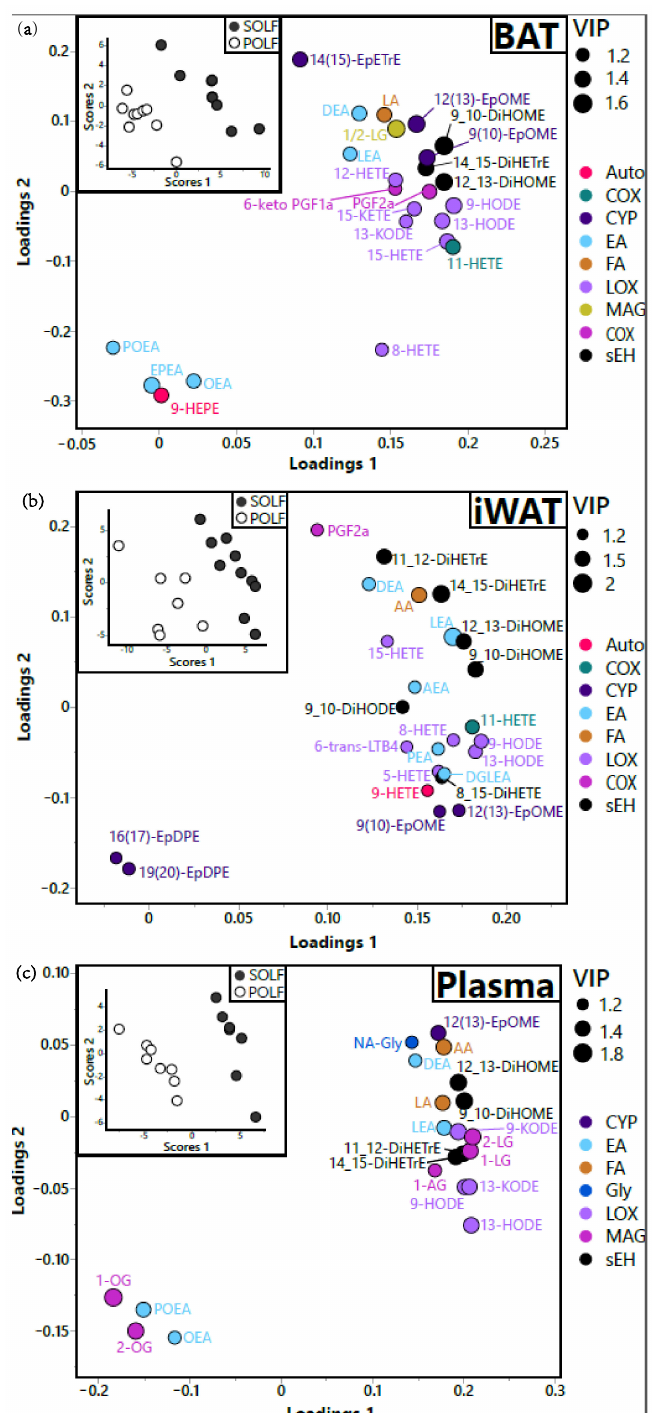
Figure 3. Influence of dietary fat on intratissue lipid mediator speciation in: ( a ) BAT, ( b ) iWAT, and ( c ) plasma. Partial least squares discriminant analysis (PLS-DA) of SOLF vs. POLF. Treatment group discrimination is shown by the SCORES panel (inset), while metabolite weightings in group discrim- ination are shown by the LOADINGS panel. Loading node color indicates metabolite enzymatic origin. Loading node size indicates metabolite variable importance in projection (i.e., VIP). Analysis was performed with all measured metabolites, but only those with VIP ≥ 1.2 are displayed for clarity purposes. N = 6–9 per group. BAT X 2 = 0.98, Y 2 = 1.22, Q 2 = 0.73; iWAT X 2 = 0.17, Y 2 = 0.15, Q 2 = 0.65; plasma X 2 = 1.3, Y 2 = 0.095, Q 2 =